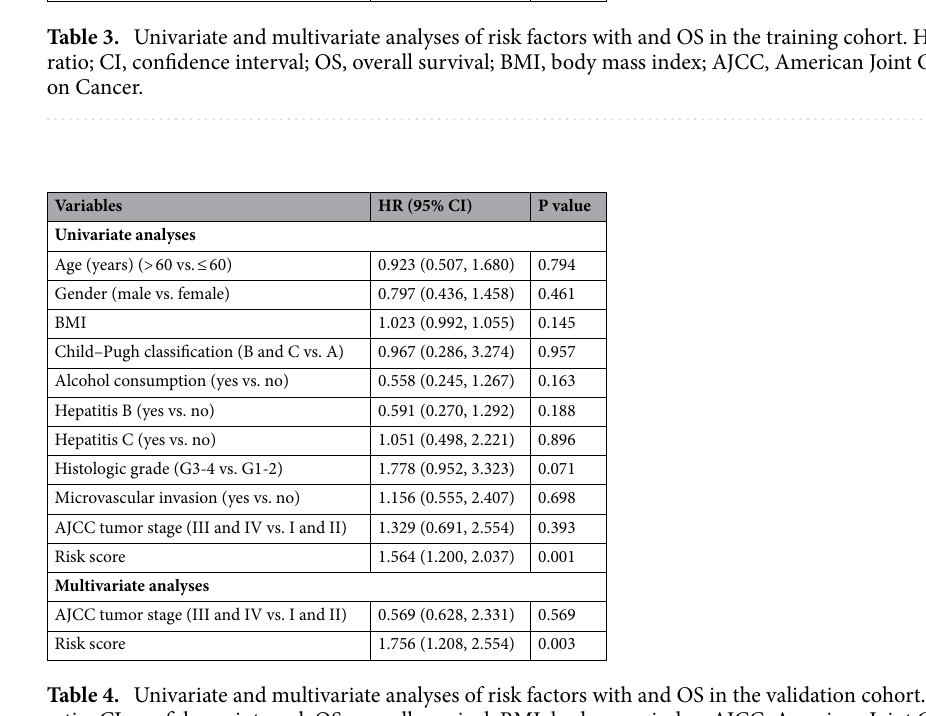
Table 4. Univariate and multivariate analyses of risk factors with and OS in the validation cohort. HR, hazard ratio; CI, confidence interval; OS, overall survival; BMI, body mass index; AJCC, American Joint Committee on